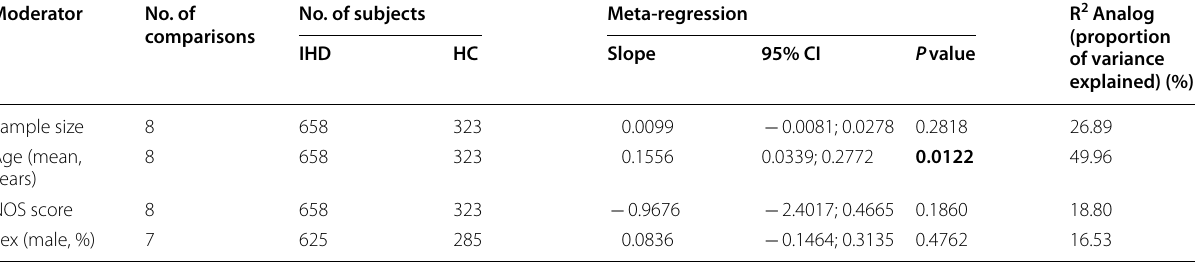
P value < 0.05 is shown in Bold